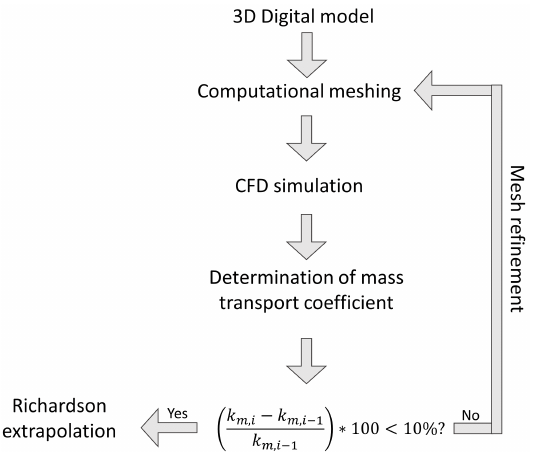
Figure 3. Computational procedure to study the mass transfer